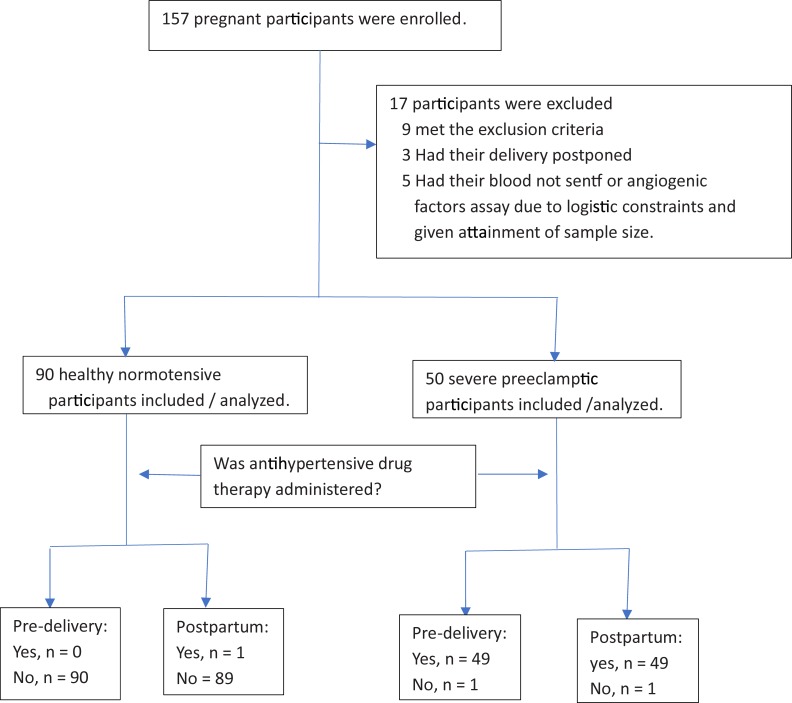
Study flow chart.